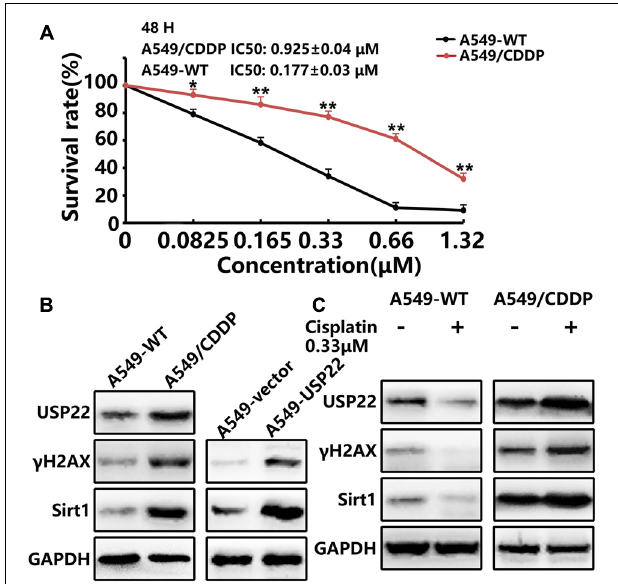
FIGURE 2 | USP22 and its downstream proteins γ H2AX and Sirt1 levels are upregulated in the cisplatin-resistant A549/CDDP cell line. (A) The sensitivity to cisplatin of A549-WT and A549/CDDP cells was detected by CCK-8. Cells were exposed to various concentrations of cisplatin for 24 and 48 h. (B) Western blot analysis of USP22, γ H2AX and Sirt1 in A549-WT, A549/CDDP, A549-vector, and A549-USP22 cells. (C) Western blot analysis of the proteins of USP22, γ H2AX and Sirt1 in A549-WT and A549/CDDP cells. Cell lines were treated continuously with either 0 or 0.33 µ M cisplatin for 48 h. Every experiment was conducted at least three times, and the average is shown (mean ± SD). ∗ P < 0.05, ∗∗ P < 0.01, significant.